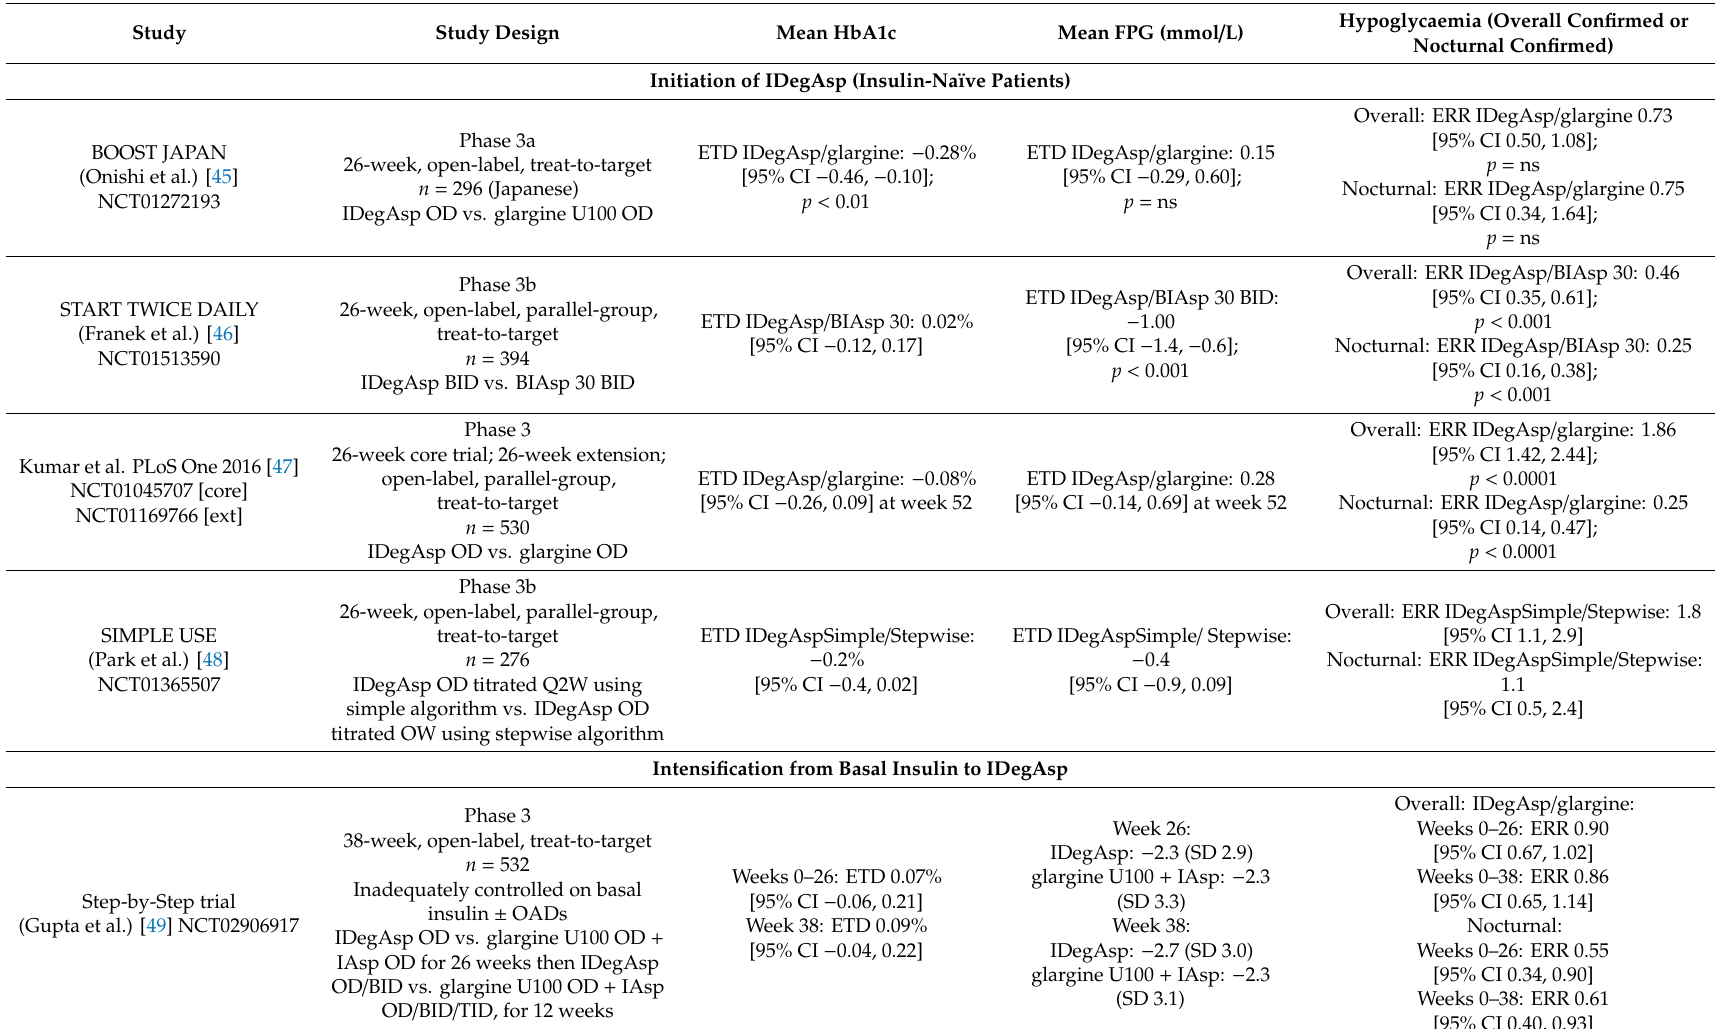
Table 1. Key phase 3 clinical trials of IDegAsp in